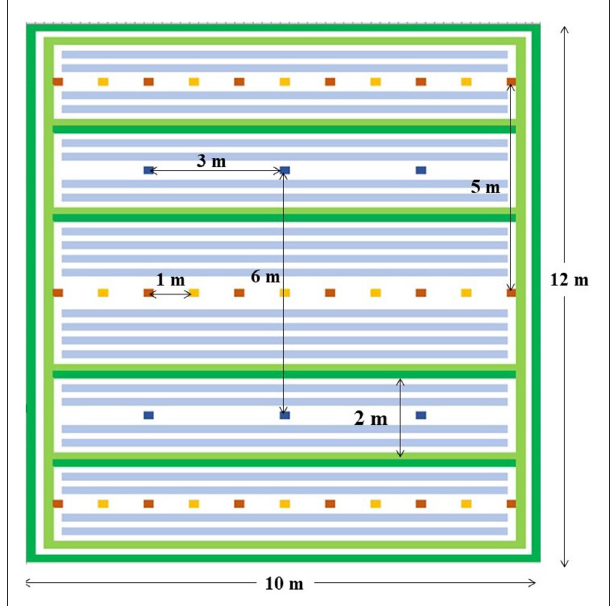
FIGURE1 Field layout of the plot with the agroecological package, T3 a green bands represent the grasses ( Pennisetum and Setaria ), orange and red cells represent the shrubs ( Calliandra and Leucena ), light blue-gray bands represent mucuna lines (in dry season months only), while dark blue cells represent banana or plantain mats. Only banana or plantain mats are present in T1 and T2 (natural weed fallow with burning, with or without the application of manure and NPK).